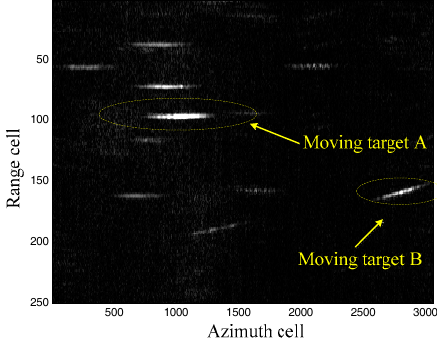
Figure 7. Keystone transform results.